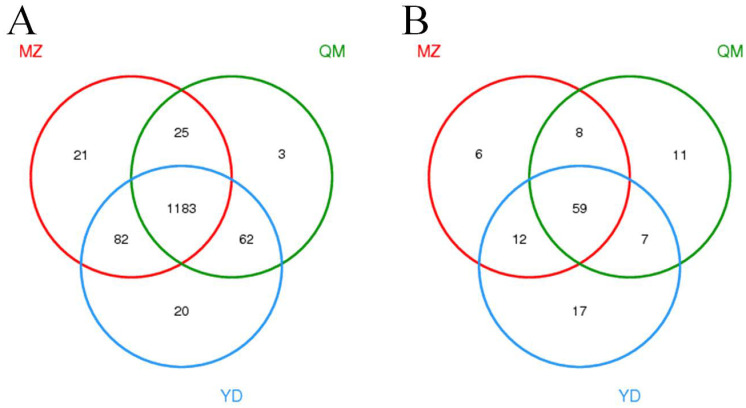
Venn diagram of bacterial (A) and fungal (B) communities in three soils.MZ = continuous cropping proso millet for 5 years, YD = continuous cropping common bean for 5 years, QM = continuous cropping common buckwheat for 5 years.